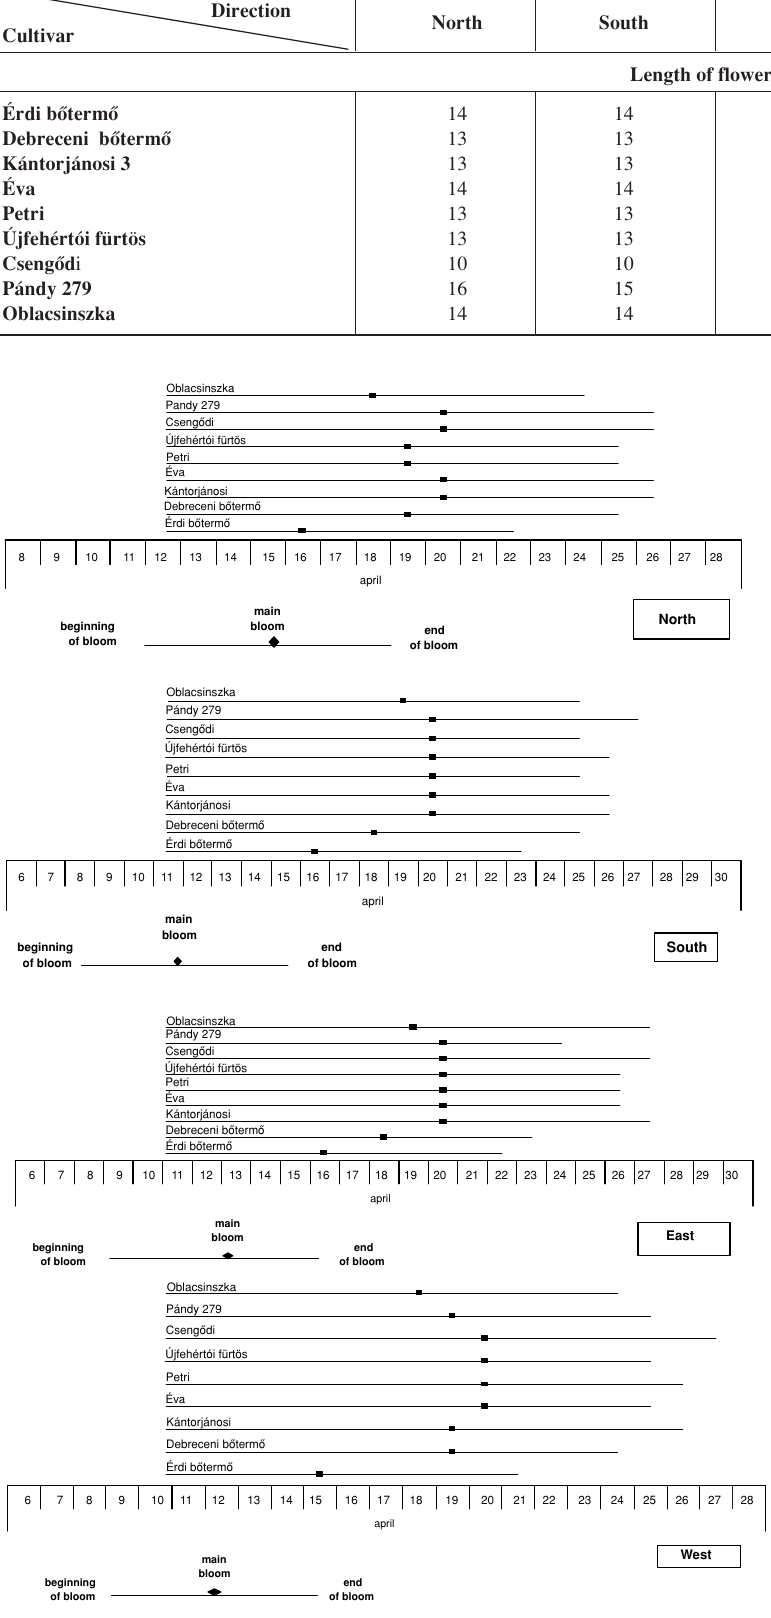
Figure 1. The blooming process of sour cherry cultivars (Hungary 2008)